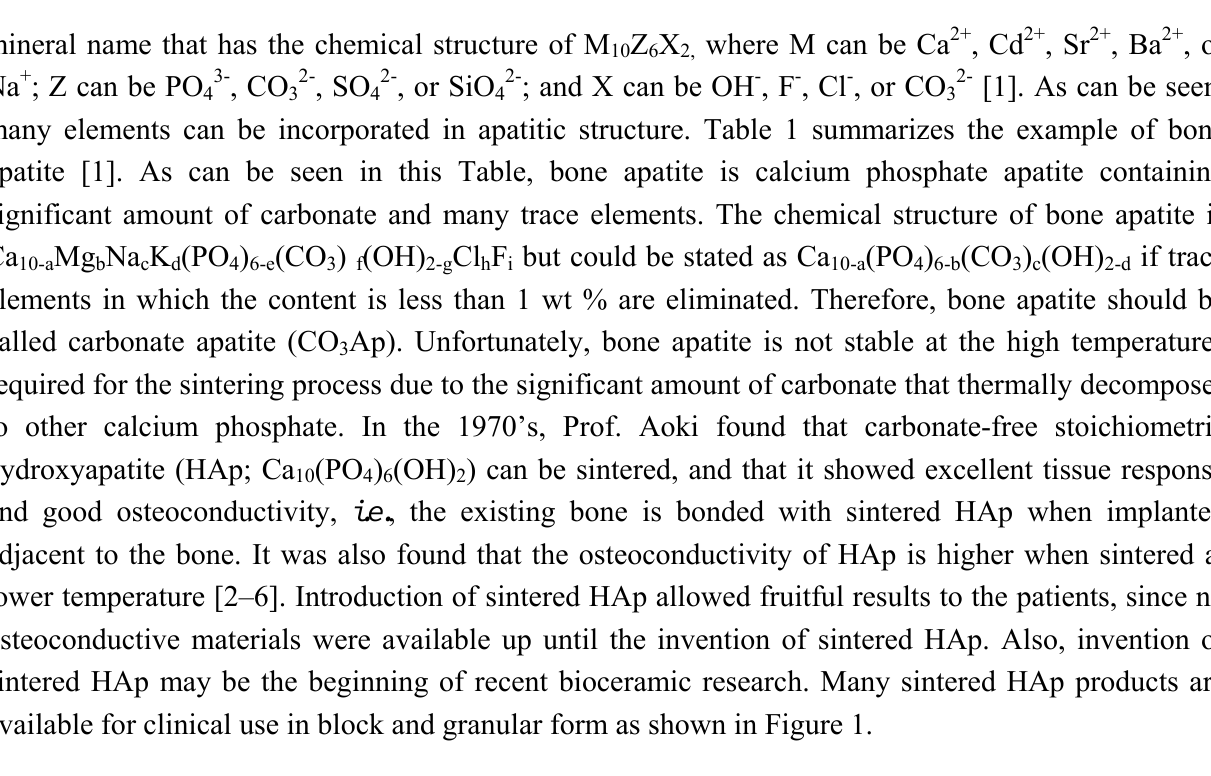
Table 1. Hard tissue components of the human adult. Weight % except for Ca/P molar ratio [1].